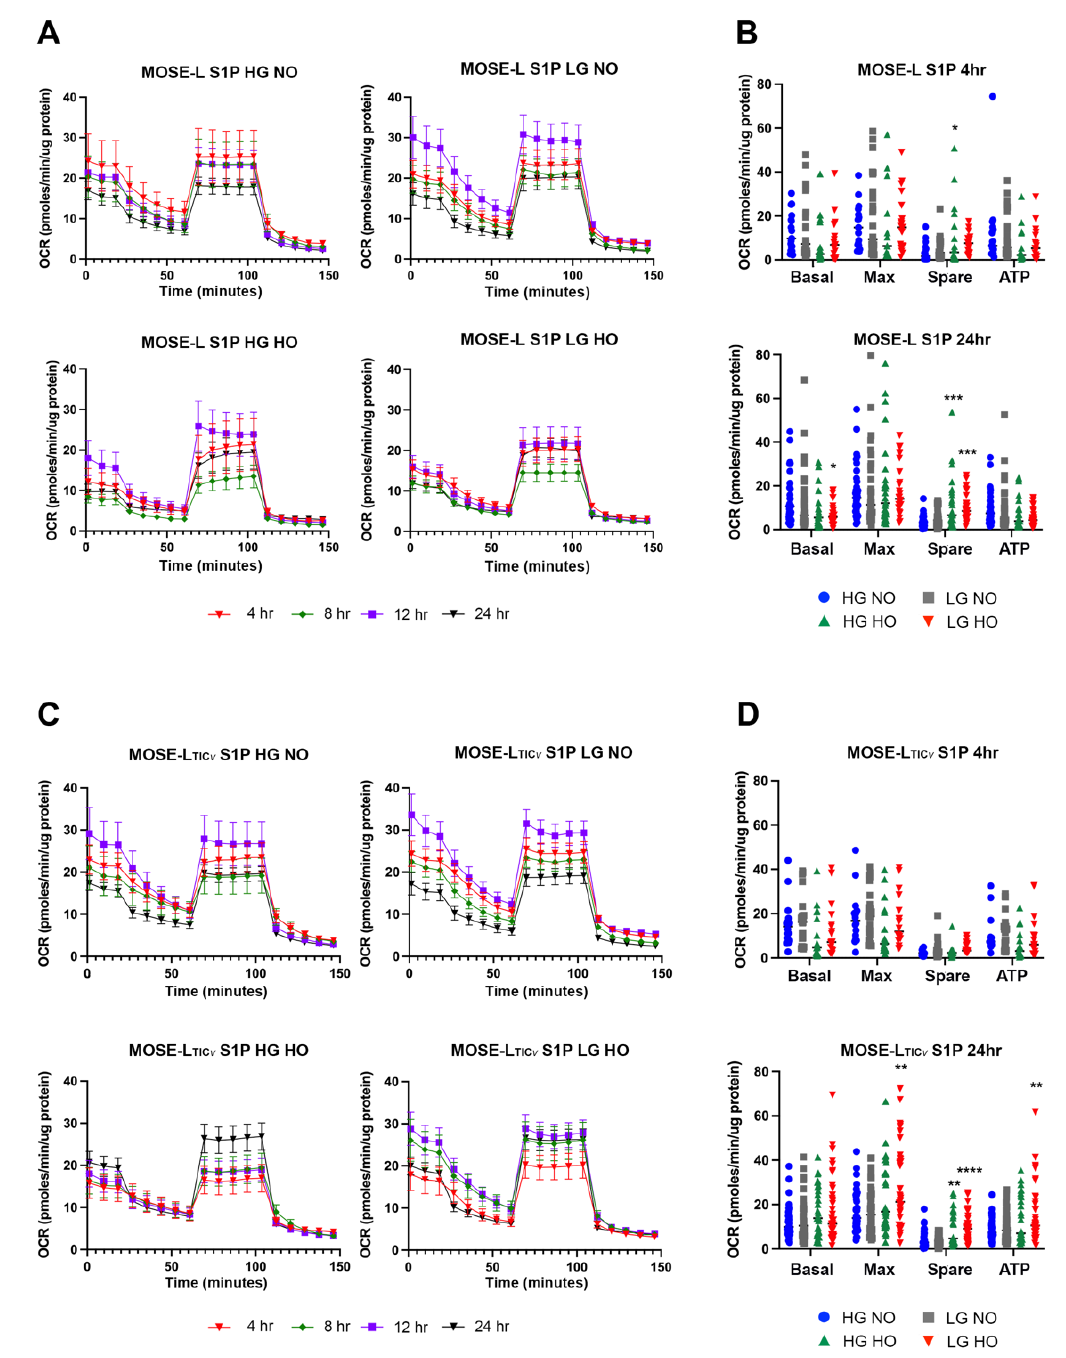
Figure 2. Oxygen consumption rate (OCR) and metabolic outputs in S1P-treated spheroids. ( A ) MOSE-L time traces, ( C ) MOSE-L TIC v time traces. Metabolic outputs were calculated from OCR trace values for ( B ) MOSE-L and ( D ) MOSE-L TIC v treated with S1P. Data are represented as the mean ± SEM and ANOVA with Dunnett’s multiple comparisons test to compare to HG NO. * p < 0.05 compared to HG NO; ** p < 0.01 compared to HG NO; *** p < 0.001 compared to HG NO; **** p < 0.0001 compared to HG NO. Abbreviations: high glucose (HG); low glucose (LG); normoxia (NO); hypoxia